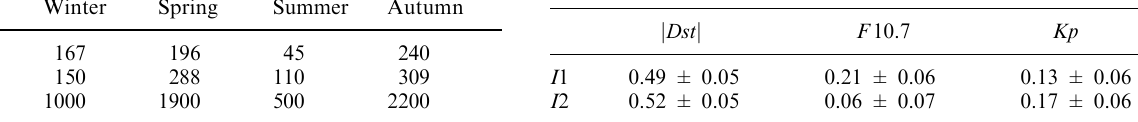
Table 2. Correlation coe(cid:129)cients calculated for whole set of